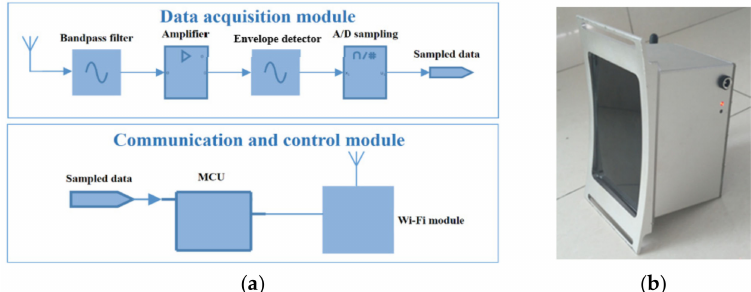
Figure 2. Designed wireless UHF Sensor: ( a ) diagram of wireless UHF sensor; ( b ) picture of wireless UHF